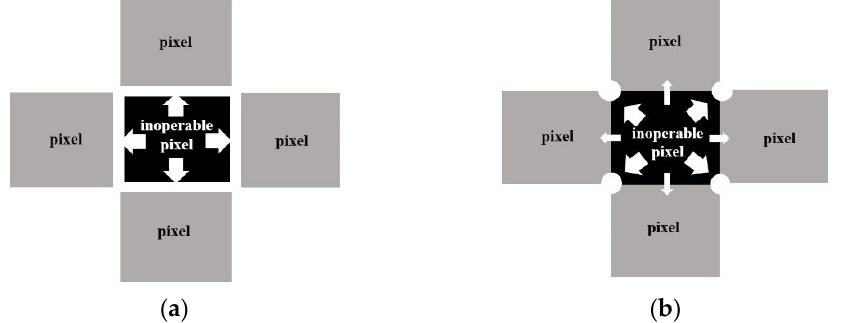
Figure 4. Schematic of suppression effect of electrical crosstalk of two structures. ( a ) Guard-ring structure. ( b ) Guard-hole structure.